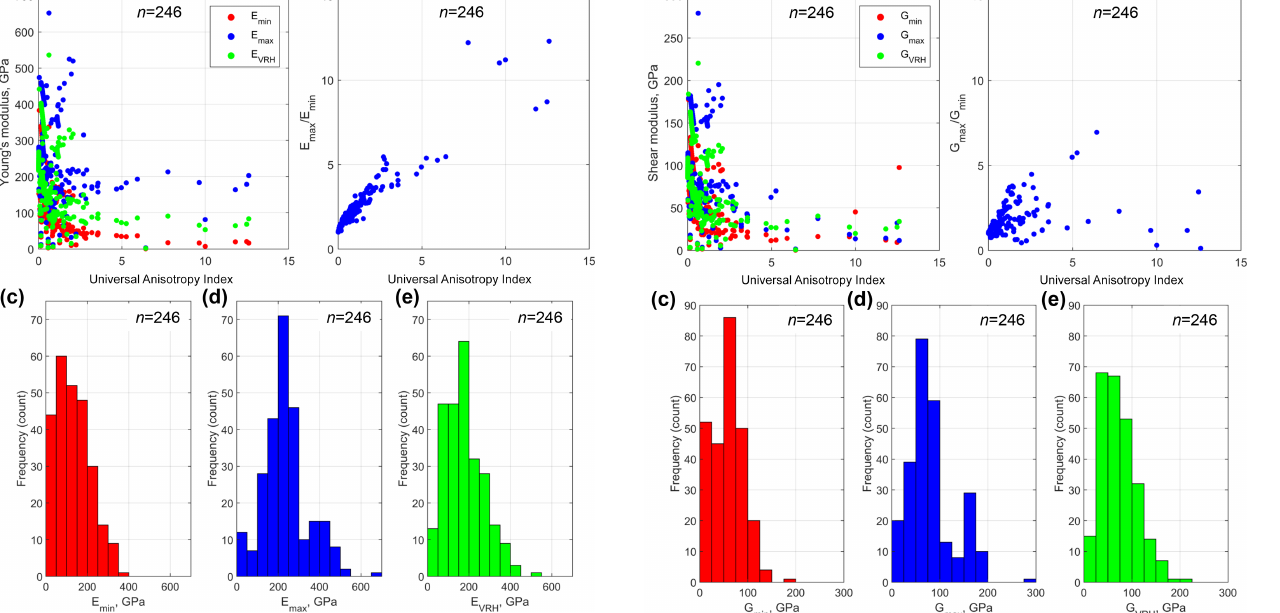
Figure 11. Anisotropy of shear modulus in rock-forming minerals ( n = 246) plotted against the Universal Anisotropy Index of Ran- ganathan and Ostoja-Starzewski (2008). G VRH is the Voigt–Reuss– Hill average of G . (b) Plot of G max /G min versus A U . (c–e) His- tograms of G min , G max and G VRH to show the distribution across all 246